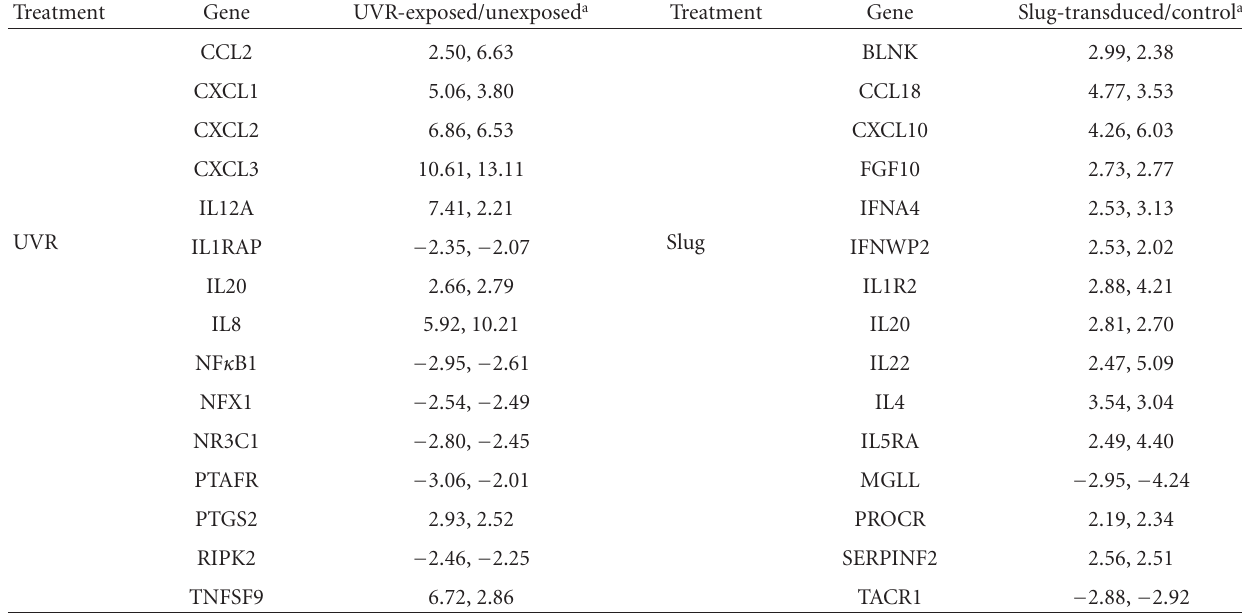
Table 1: Altered expression of proinflammatory and immunomodulatory mediators by normal human melanocytes.